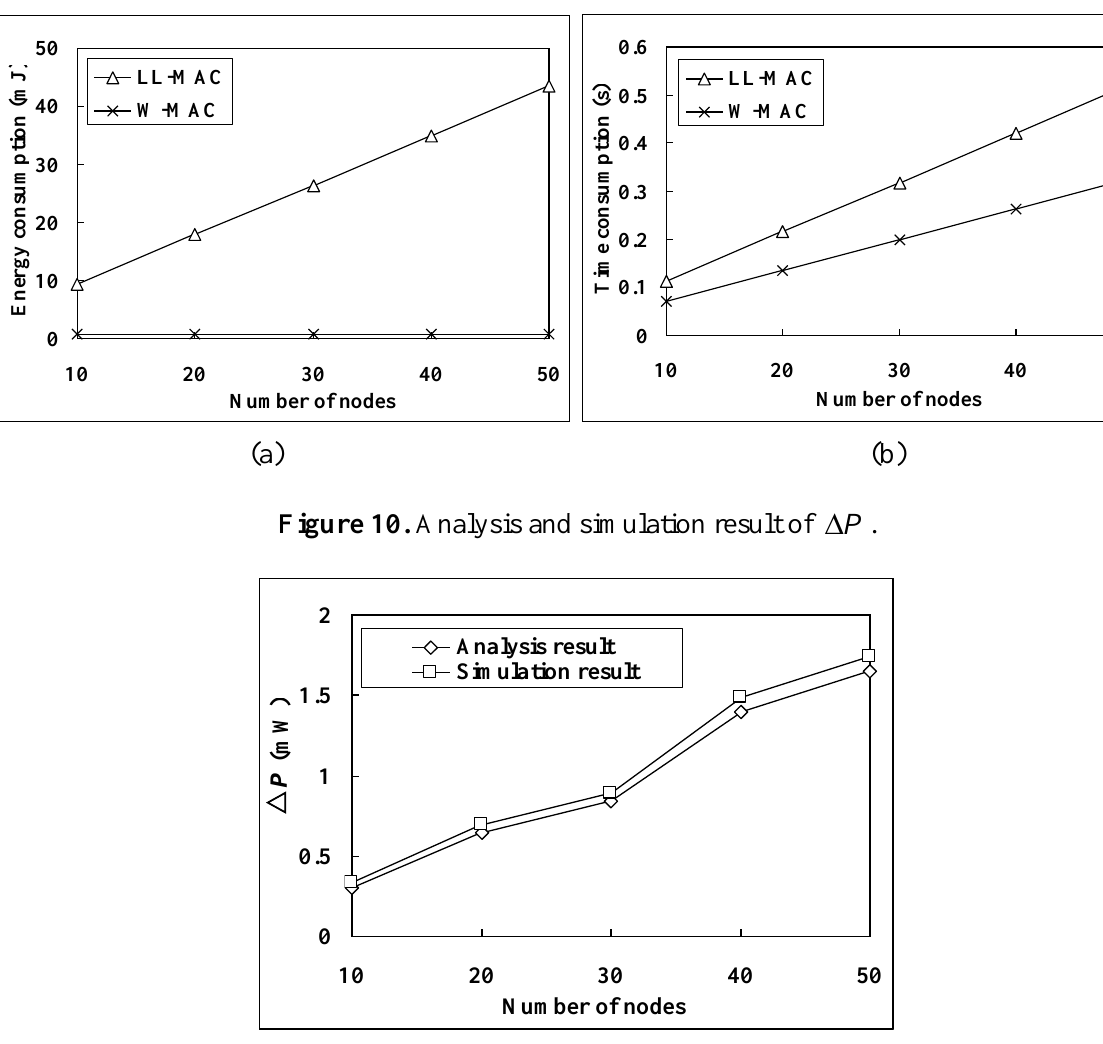
Figure 9. The control overhead of LL-MAC and W-MAC: (a) energy consumption and (b) time consumption.